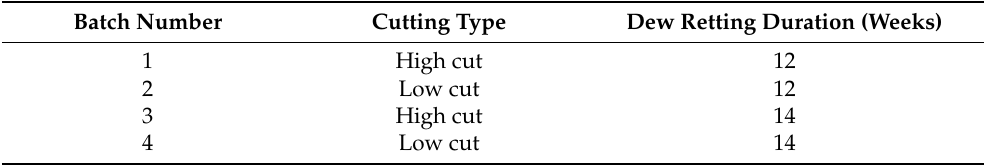
Table 1. Harvesting details of the four batches of oleaginous flax straw used in this